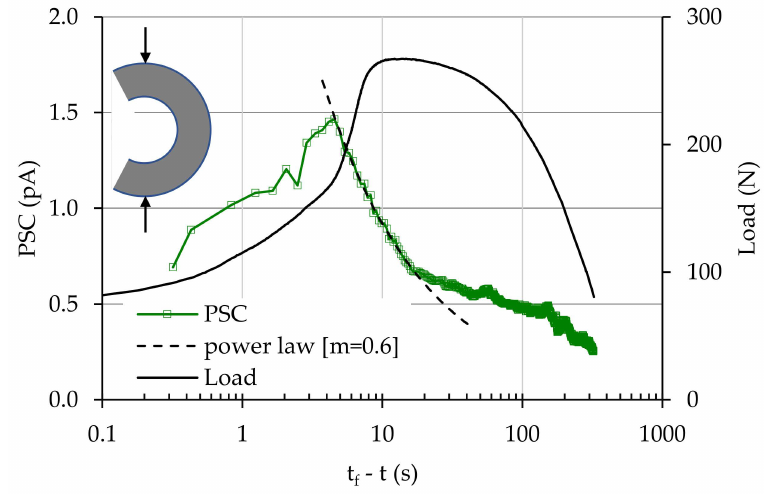
Figure 16. The temporal variation of the PSC for a CSR specimen, together with the respective variation of the applied